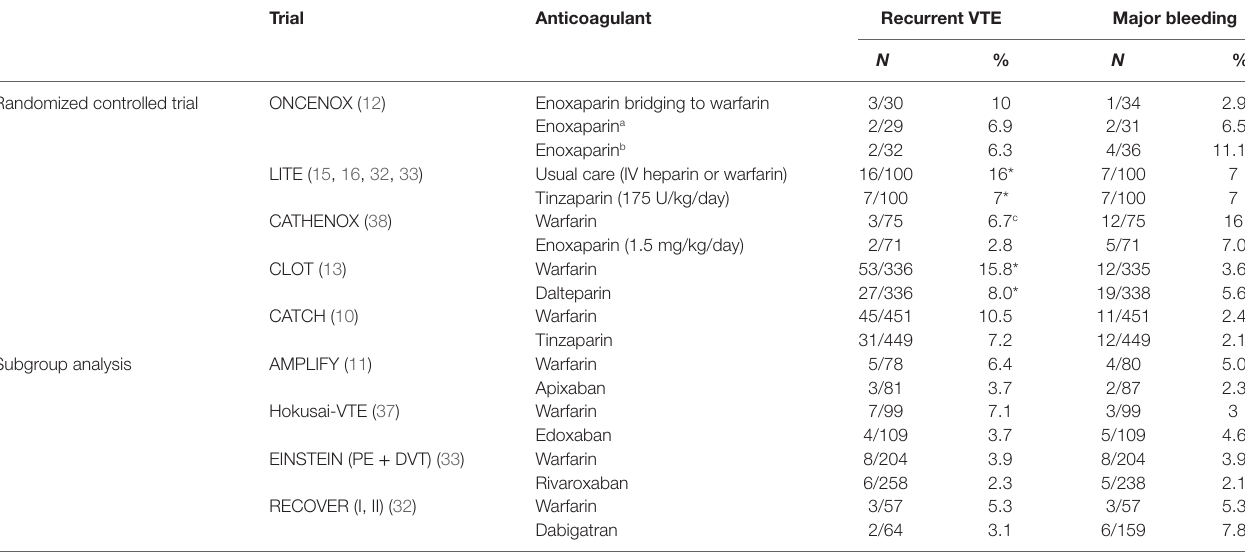
TABLe 1 | Summary of randomized data for anticoagulant treatment of cancer-associated venous thromboembolism (VTE)